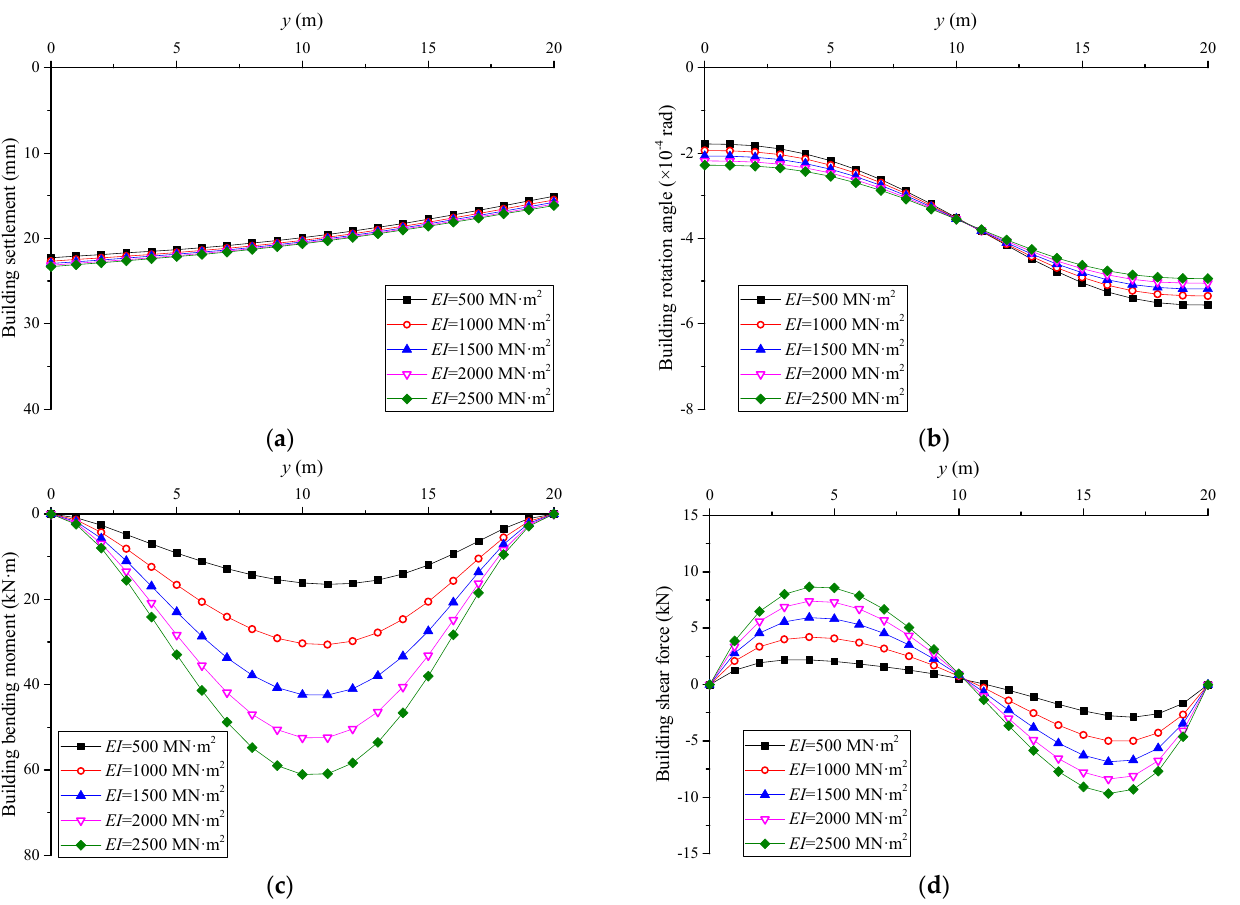
Figure 13. Building response with different bending stiffness: ( a ) settlement; ( b ) rotation angle; ( c ) bending moment; ( d ) shear force.